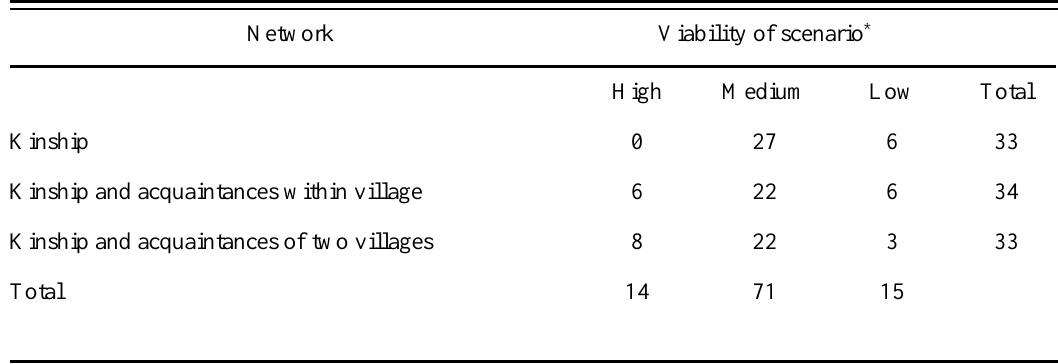
Table 4. Proportion (%) of scenarios under different levels of viability based on three types of social